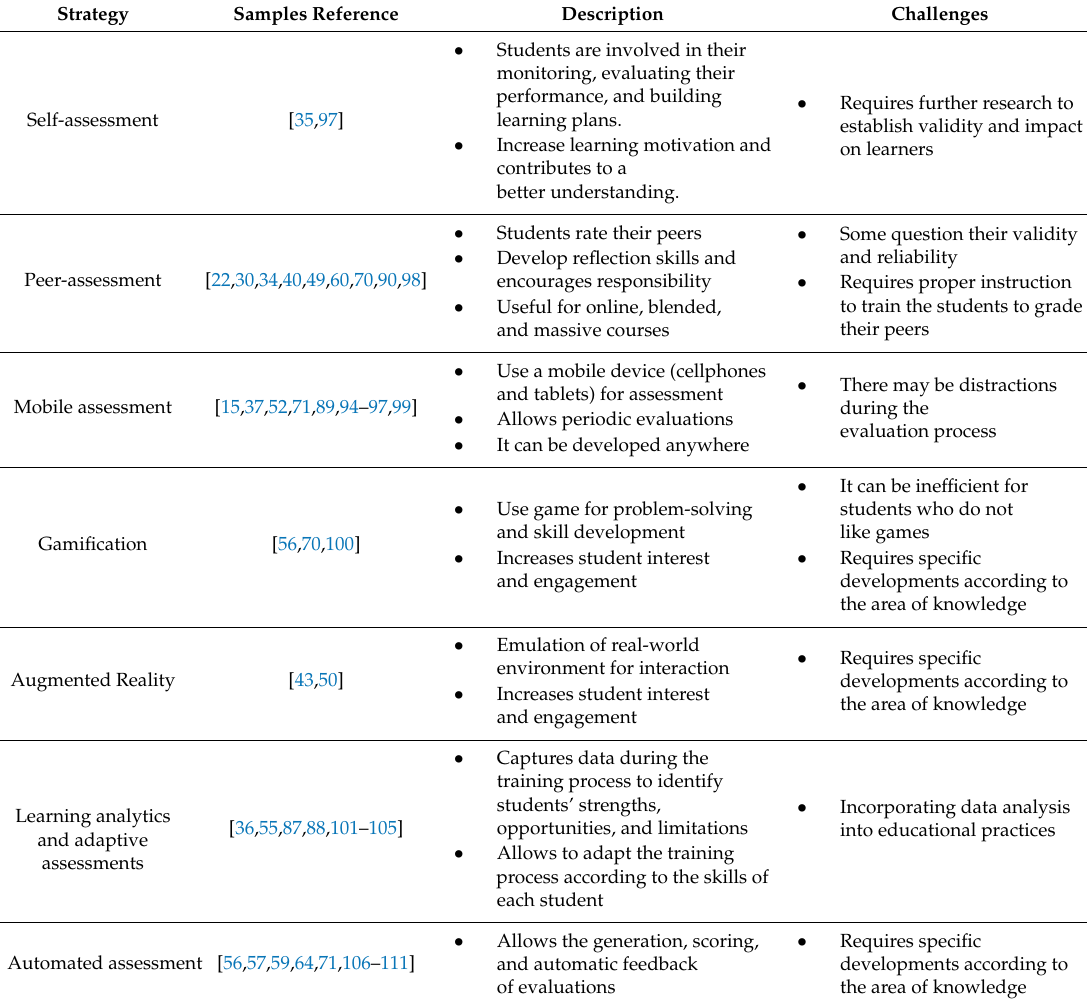
Table 3. Key strategies to incorporate ICT-mediated assessment into learning